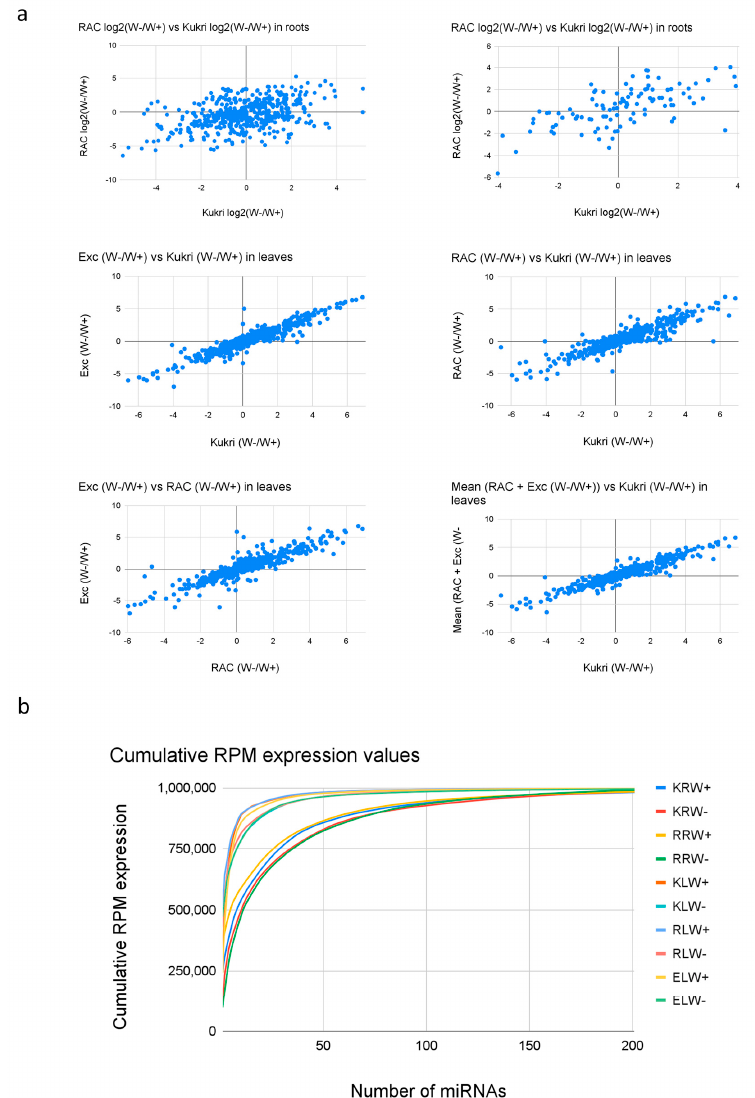
Figure 5. ( a ) Comparison of W − /W+ ratios of miRNA expression between samples. Upper row shows the fold-change comparison between RAC and Kukri in roots for all microRNAs ( left ) and only those with average RPM values >1000 RPM expression ( right ). Removing low expressed microRNAs increases the correlation from 0.416 to 0.638. The middle and upper row show the fold-change of the comparisons in leaves; Excalibur vs. Kukri, RAC vs Kukri and Excalibur vs. RAC and the mean FC of Excalibir and RAC vs Kukri. All comparisons show correlation coefficients (>0.9) much higher than those in roots. ( b ) Cumulative expression of miRNAs in all samples. More microRNAs show high expression values in roots when compared to leaves which suggest a higher complexity of the RNA pool in